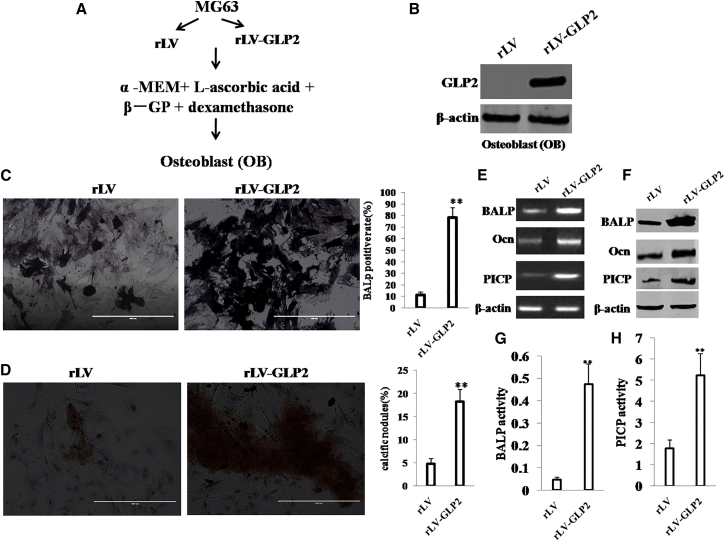
GLP2 Promotes the Directed Differentiation from MG63 to Osteoblast (OB)(A) The schematic digram illustrates a model of osteoblast induced from human osteosarcoma cell line MG63 with dexamethasone,β- glycerophosphate and mlascorbic acid(Asc) for 21days. (B) Western blotting with anti-GLP2 in induced OB. β-actin as internal control. (C, left) The photography of BALP staining. (C, right). The BALP positive rate. (D, left) The photography of calcific nodules after induction of OB. (D, right) The rate of calcific nodules in OB. (E) RT-PCR analysis for BALP, Ocn and PICP in induced OB.β-actin as internal control. (F) Western blotting with anti-BALP, anti-Ocn, anti-PICP in induced OB. β-actin was used as an internal control. (G) Cell BALP activity assay. Data are means of value from three independent experiment (error bar ± SEM; **p < 0.01). (H) Cell PICP activity assay. Data are means of value from three independent experiment (error bar ± SEM; **p < 0.01).